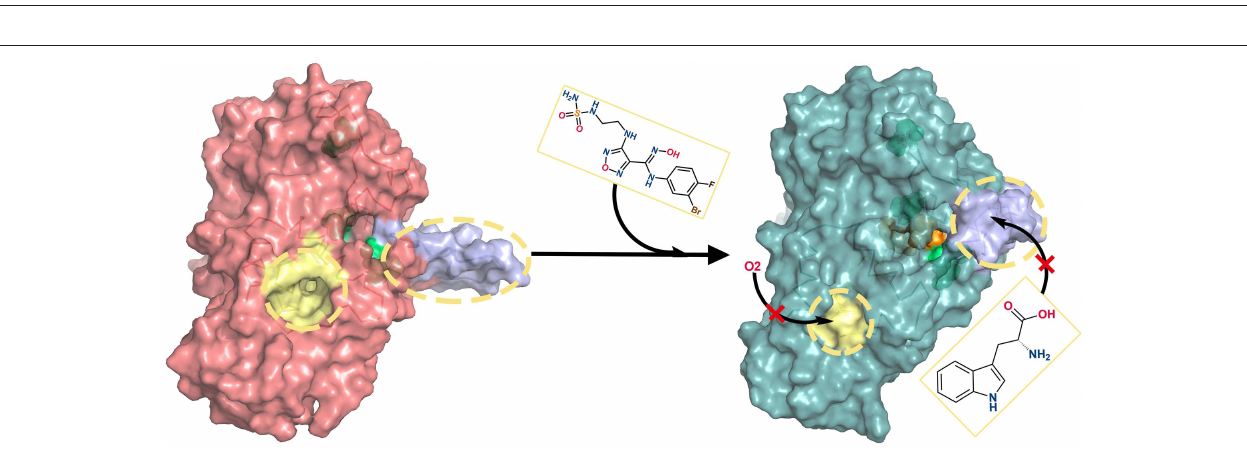
FIGURE 9 | Detailed conformational analyses of R231. Angle, distance and frequency analysis of R231 in IDO and IDO-BBJ systems (A–C) . Distance and RDF analysis between INCB024360 and R231 (D–F) .